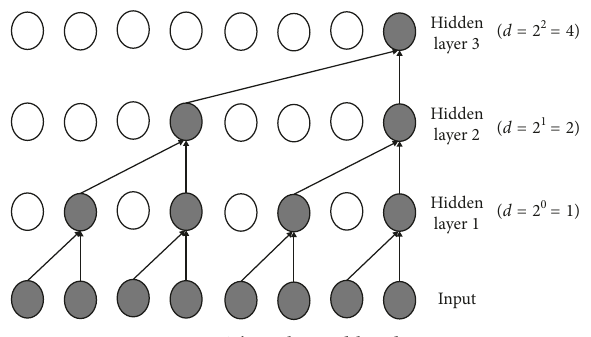
Figure 1: Three-layer dilated